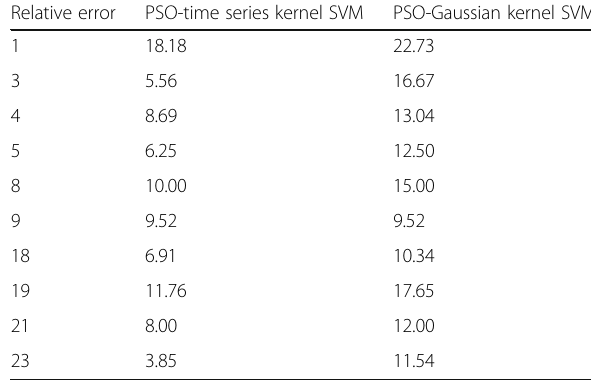
Table 8 Partial relative error of a certain day in